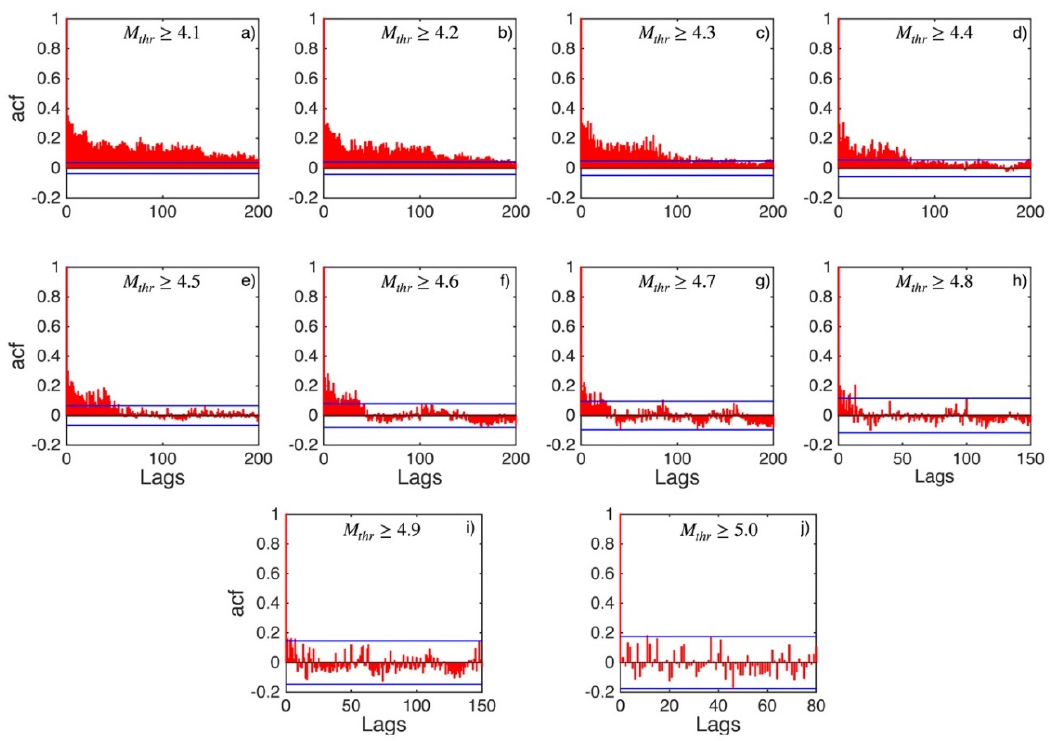
Figure A7. ACF values (red stems) and their 95% confidence intervals (blue lines) for Eastern Hellenic Arc (sub − area 4) for magnitude thresholds ( M thr ) varying from 4.1 to 5.0 (sublots a – j ).